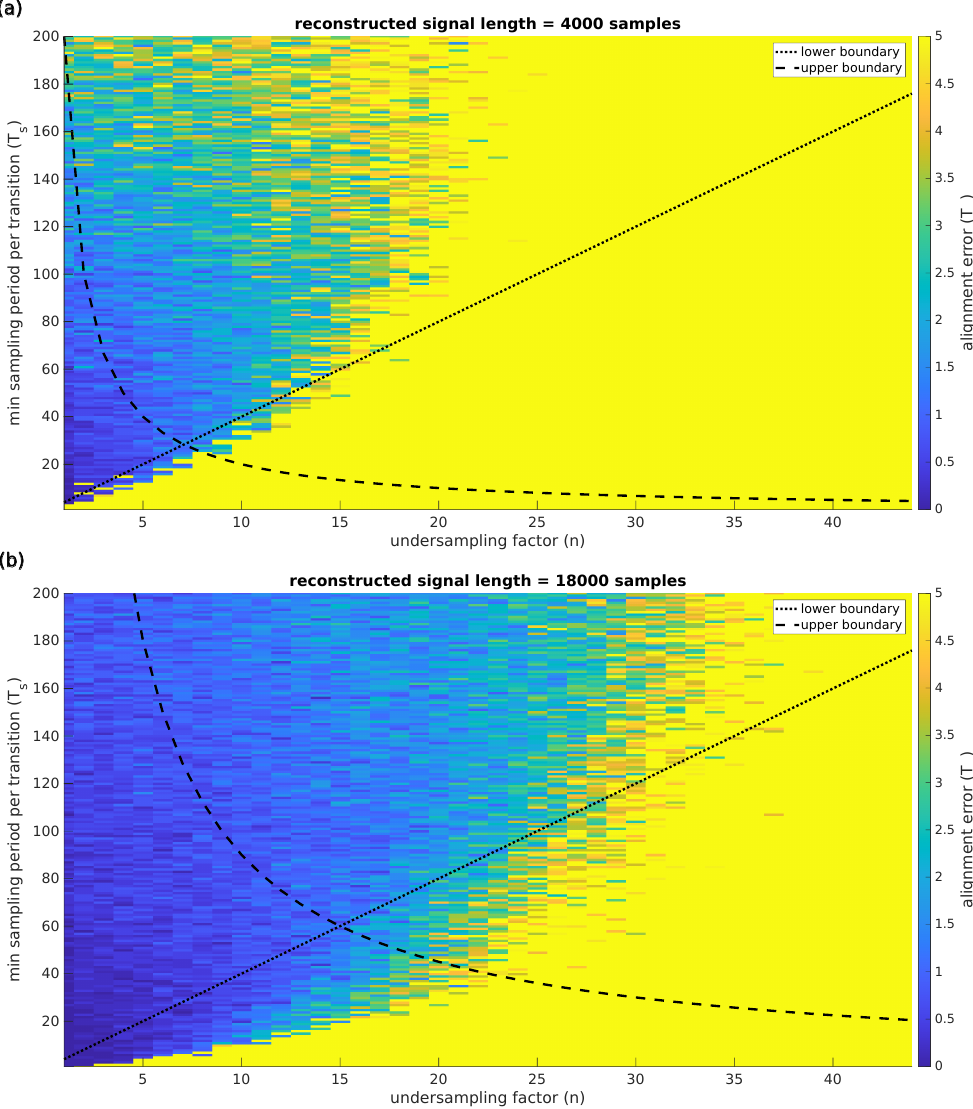
Figure 7. Results of the synchronization alignment error calculation using a Monte Carlo simulation. Subfigure ( a ) presents the maximum alignment error for a signal of 4000 samples, meaning the maximum difference over one-hundred iterations in a calculated timeshift between the synchroniza- tion calculation using traditionally sampled signals and the same calculation using undersampled signals. Subfigure ( b ) demonstrates the impact of the signal length on the synchronization accuracy and boundaries by using a signal length of 18,000 samples. Using a larger signal length places the upper boundary higher, leading to a higher achievable maximum undersampling factor with a single sample period synchronization